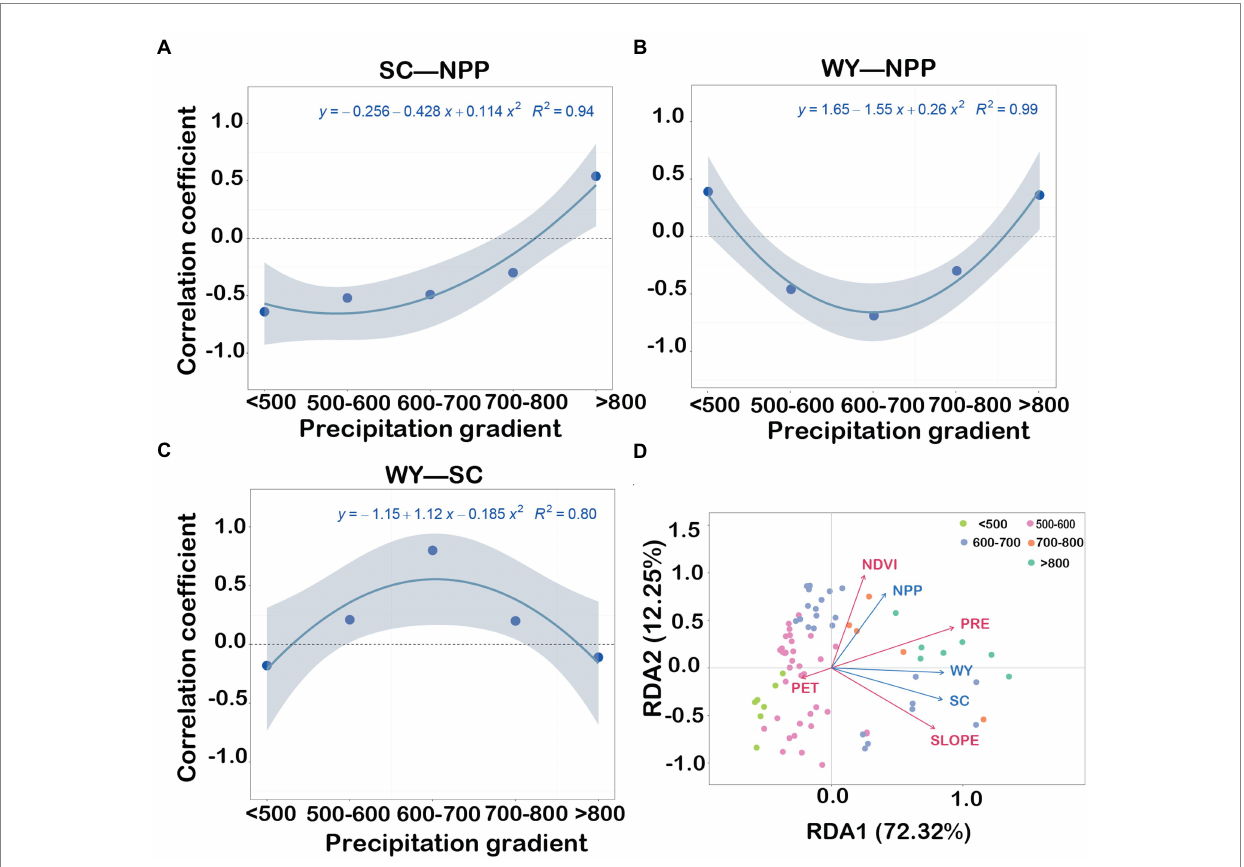
FIGURE 4 Changes in ES relationships between precipitation gradients [ (A) soil conservation and NPP; (B) water yield and NPP; (C) water yield and soil conservation and RDA analysis (D) ]. SC, soil conservation; WC, water yield; and PET, potential evapotranspiration. Explanation of ESs by influences in RDA and the permutation test result is 0.002, the explanatory variables account for 85.1% (adjusted explained variation is